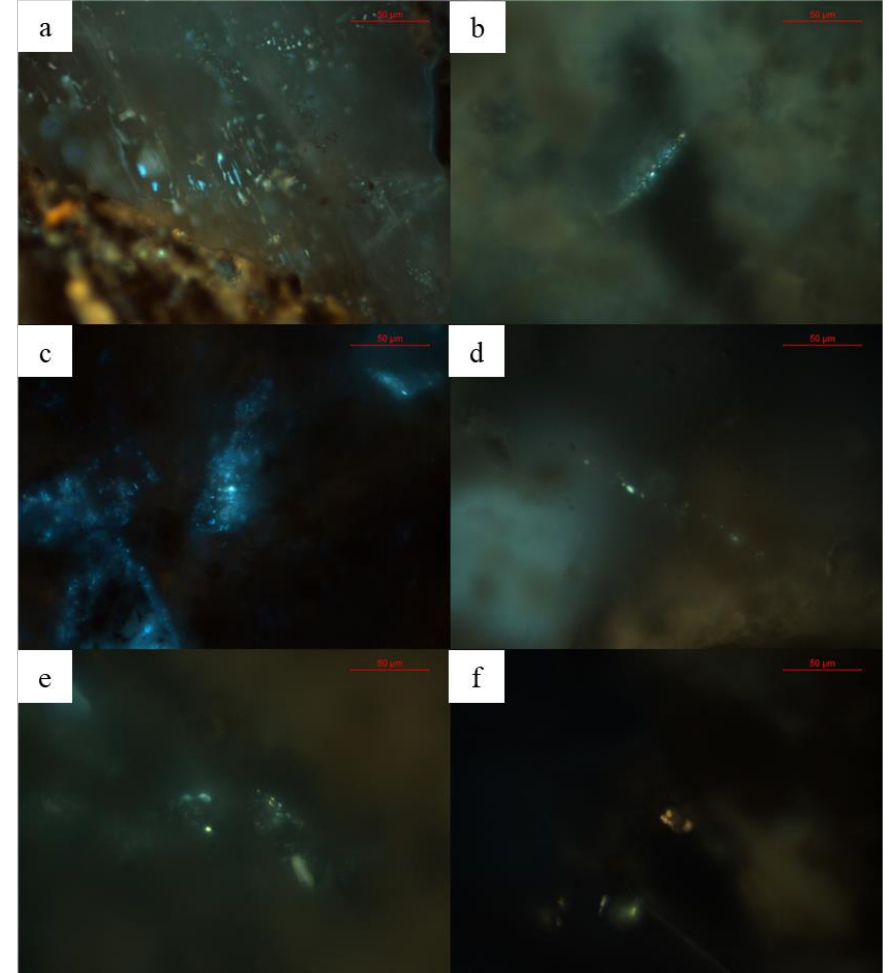
Figure 8. Microscopic photos of different fluorescent hydrocarbon inclusions in reservoir. ( a ) Well YB4, 3871 m, distributed along the micro-crack of analcime cement, showing blue, yellow, yellow- green or blue-green fluorescent hydrocarbon inclusions ; ( b ) well M19, 3526.7 m, distributed in belts along microcracks after diagenesis of quartz grains, showing yellow-light blue fluorescent hydro- carbon inclusions; ( c ) well DT1, 5695.4 m, distributed along feldspar dissolved pores, showing blue fluorescent hydrocarbon inclusions; ( d ) well D13, 4207.5 m, distributed in belts along the micro- fractures after the diagenesis of quartz grains, showing light yellow fluorescent hydrocarbon inclu- sions; ( e ) well D15, 4249 m, distributed in belts along micro-fractures after diagenesis of quartz grains, showing yellow, blue or yellow-green fluorescent hydrocarbon inclusions ; ( f ) well M19, 3534.1 m, distributed in belts along micro-fractures after diagenesis of quartz grains, showing yel- low fluorescent hydrocarbon inclusions.